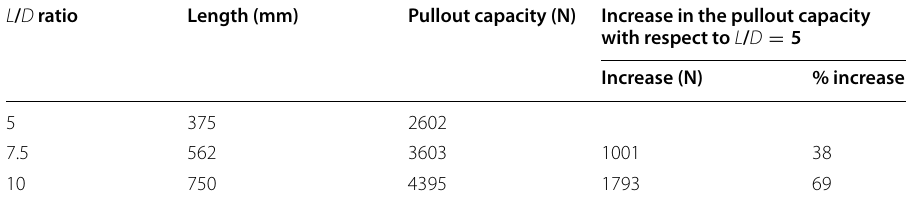
Table 4 Effect of the L / D ratio on the pullout capacity of a 75 mm diameter single GPA